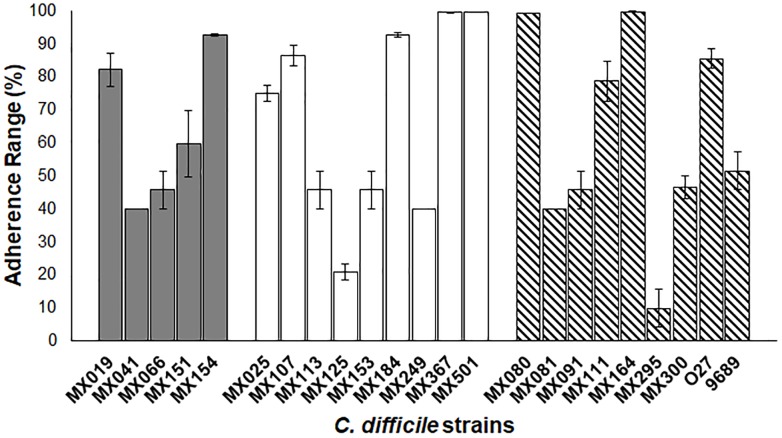
Adherence of NTCD strains in Vero cells. Monolayers of Vero cells were incubated with each strain. Cell adherence efficiency was measure as described previously. Gray bars: cdtB+tcdA+tcdB+ strains. White bars: cdtB−tcdA−tcdB− strains. Striped bars: control toxigenic strains. The data presents and standard deviation are for three independent experiments. p > 0.05.